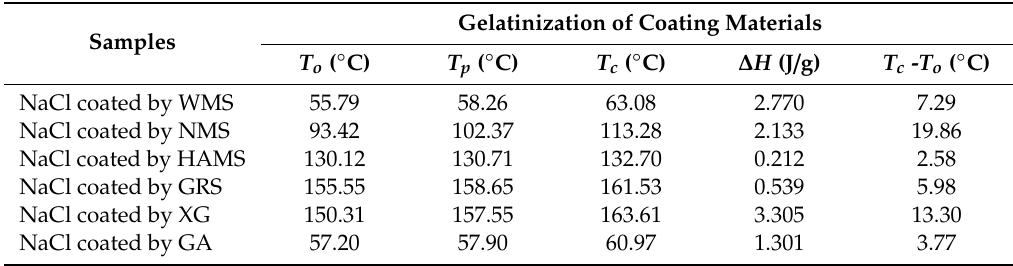
Table 3. Thermal properties of NaCl-coated microparticles treated with heat moisture and annealing a .